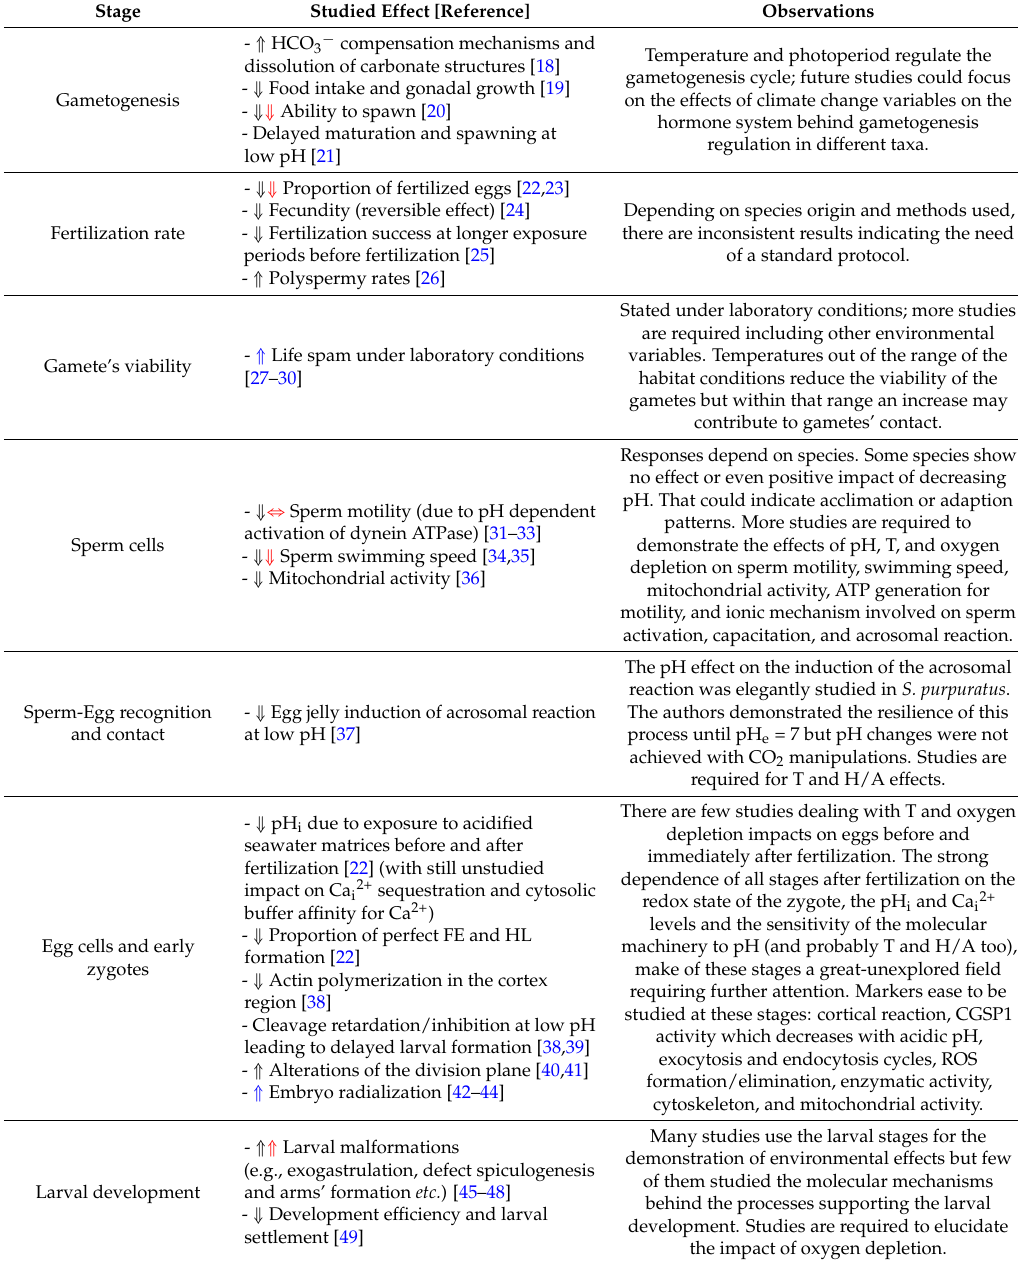
Table 1. Processes under the influence of changing climatic conditions. Environmental variables: pH (in black), Hypoxia/Anoxia (in blue), Temperature (in red). ò = increase; ó = decrease; ô = no effect. Detailed descriptions in the